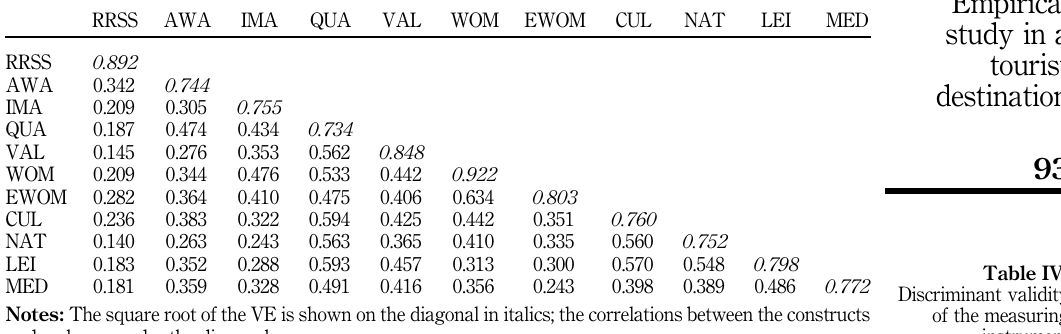
Table IV. Discriminant validity